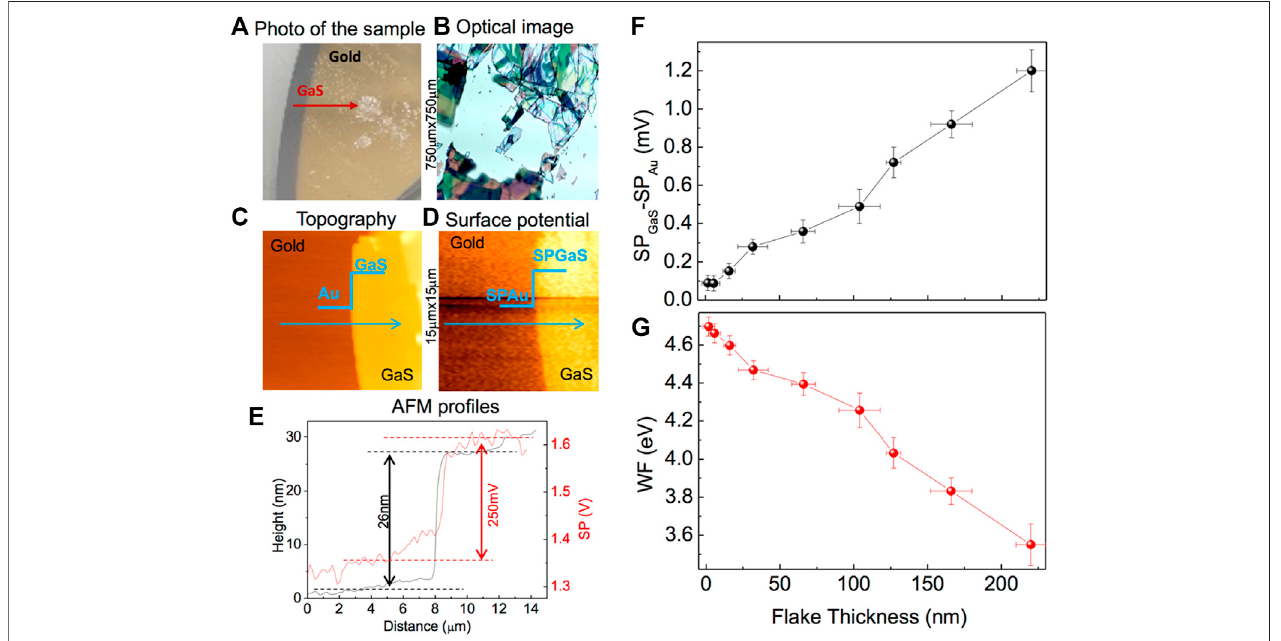
FIGURE 5 | (A) Picture of GaS fl akes on gold; (B) optical image of a 750 μ m × 750 μ m area of GaS fl akes (C,D) examples of 15 μ m × 15 µm topographic and SP mapsfora26-nm-thickGaS fl ake. (E) Representativetopographical(blackline)andSP(redline)pro fi lesforaGaS fl akewith26-nmthicknessagainstgold. (F) Thickness dependence of the difference in surface potential (SP) between gold and GaS. (G) Thickness dependence of the GaS work function (WF).